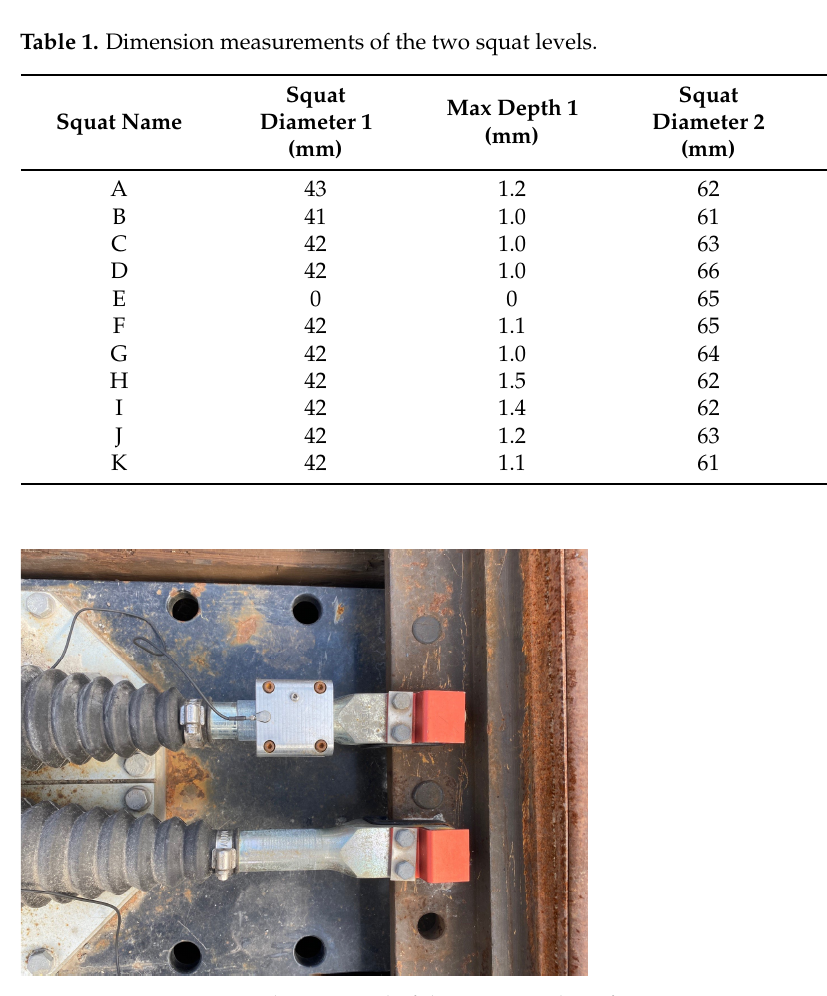
Figure 3. Sensor mounted on one rod of the point machine for extra